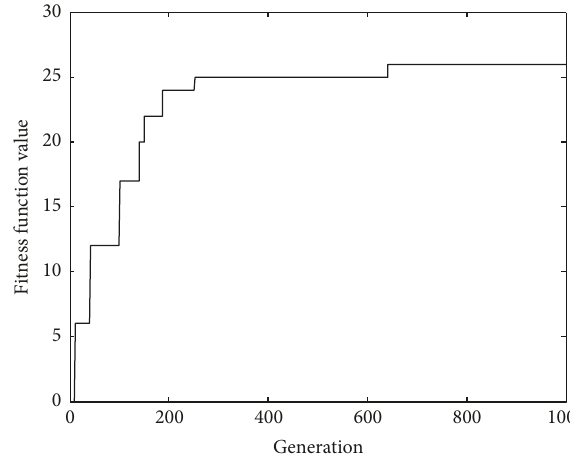
Figure 6: Variation of the fitness function